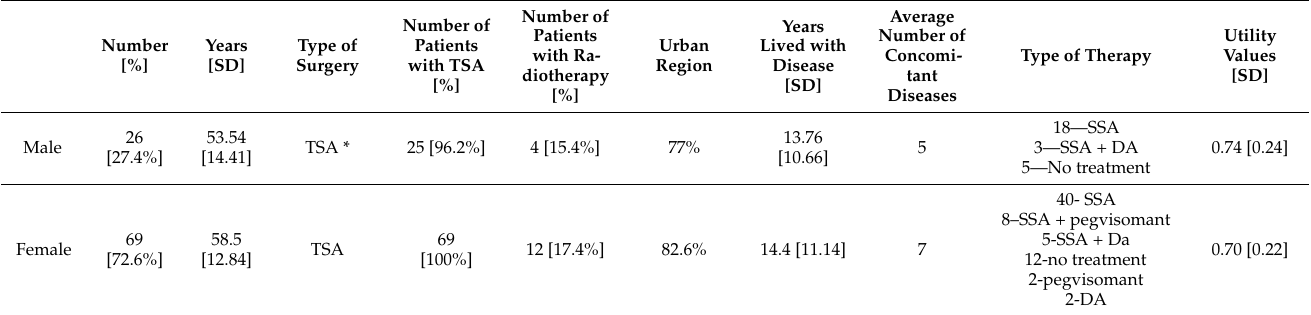
Table 4. Characteristics of the respondents.